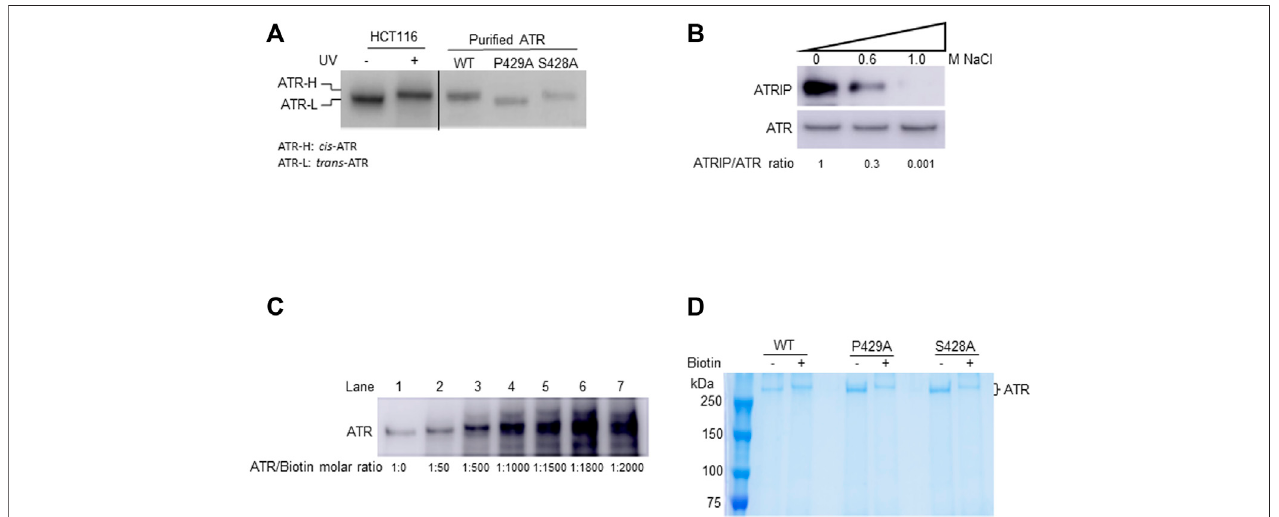
FIGURE1 | In-solution biotinylationof ATRproteins. (A) Recombinant FLAG-ATR WT,P429A, and S428A proteins were puri fi ed from HEK293T cells. Puri fi edWT andS428AproteinshavethesameelectrophoreticmobilityasendogenousATR-Hpuri fi edfromthecytoplasmicfractionofUV-treatedHCT116cells,butP429Aprotein migrates as ATR-L as analyzed by Western blotting in 3 – 8% gradient SDS-PAGE. (B) FLAG-ATR protein was immunoprecipitated and washed with increasing concentrations ofNaClsolutiontoremove bound proteins. ATRIP forms atightcomplexwith ATRand isef fi ciently removed bywashing with1M NaCl. TheATRIP/ ATR ratios were normalized to the ratio at zero salt concentration. (C) Analysis of the mass of ATR-WT after biotinylation using increasing concentrations of sulfo-NHS- LC-biotin on 8% SDS-PAGE. ATR (2 µM) was biotinylated with sulfo-NHS-LC-biotin at different molar ratios and analyzed by Western blotting using ATR antibody. (D) 2 µM each ofFLAG-ATR WT, P429A, and S428A proteins puri fi ed using FLAG beads, run on 8% SDS-PAGE with and without biotin (1,000 molar excess) modi fi cation, and visualized by Coomassie staining. Protein bands were excised and digested with trypsin for mass spectrometry